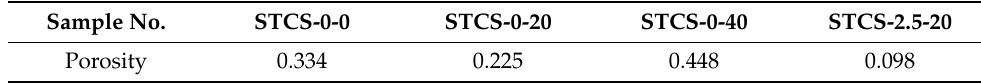
Table 9. Porosities of different STCS. Sample